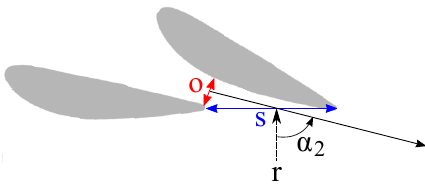
Figure 4. Estimation of α 2 by the sine